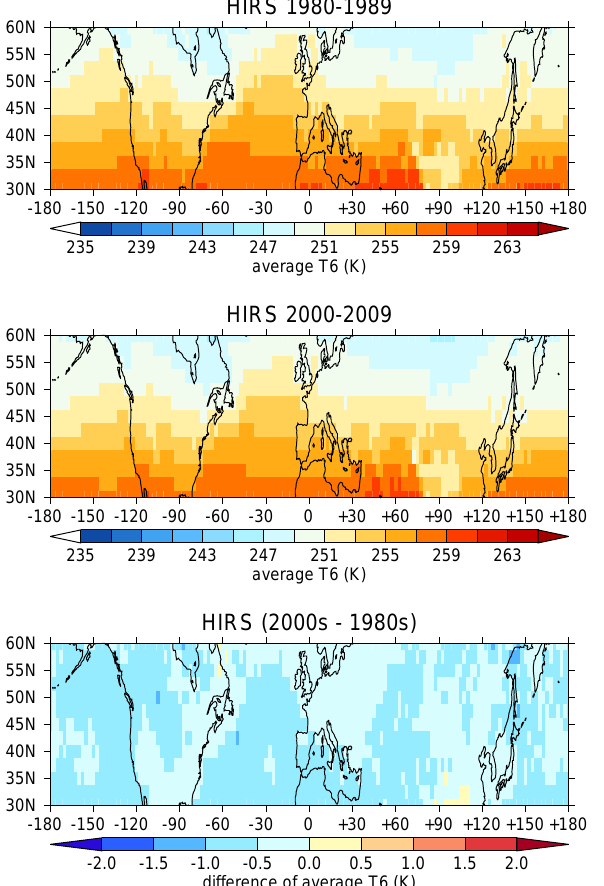
Fig. 8. As figure 6, but for T 6 . Figure 8. As Fig. 6, but for T 6 .